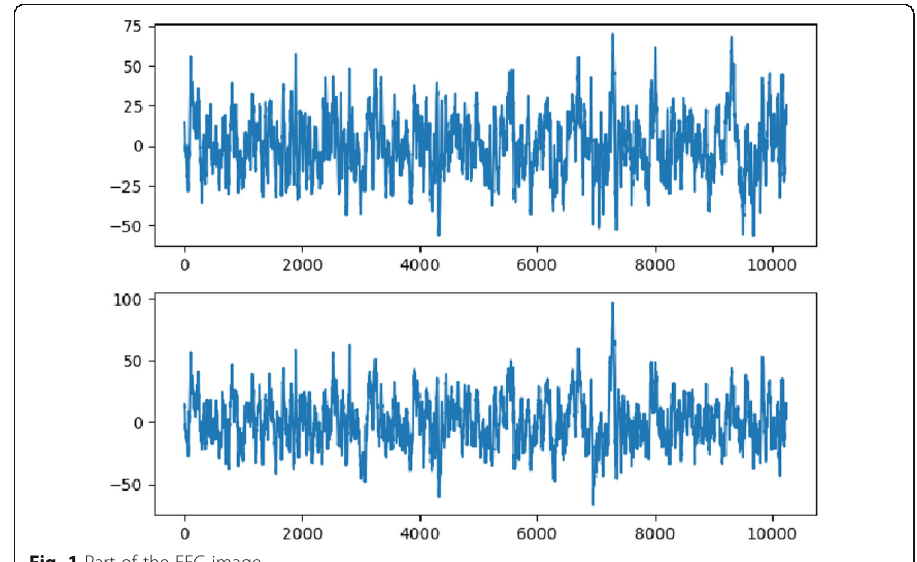
Fig. 1 Part of the EEG image